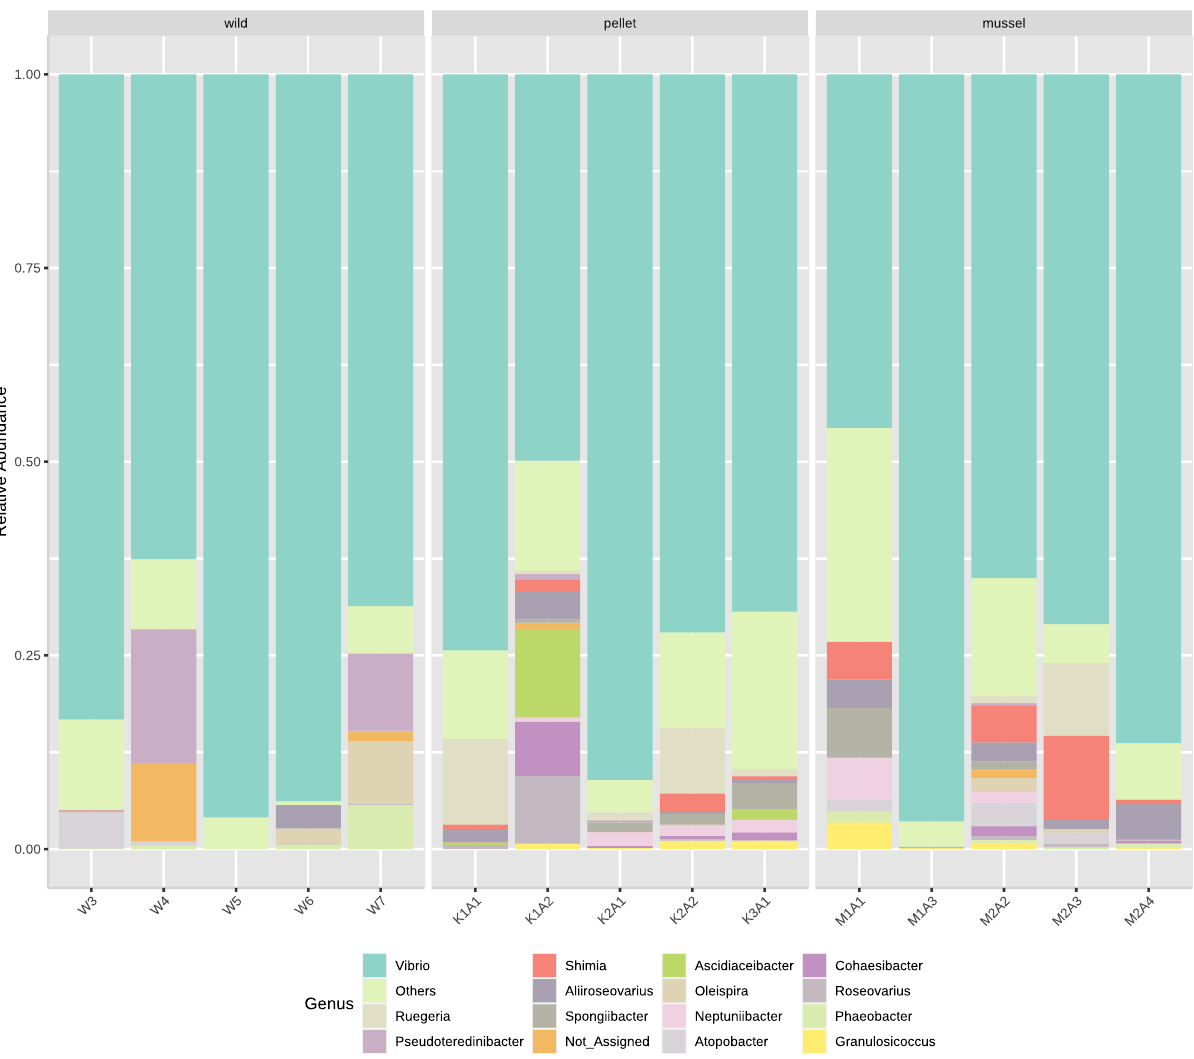
Figure 2. Relative abundance of bacterial features in the hindgut libraries of juvenile P. ornatus at genus level.